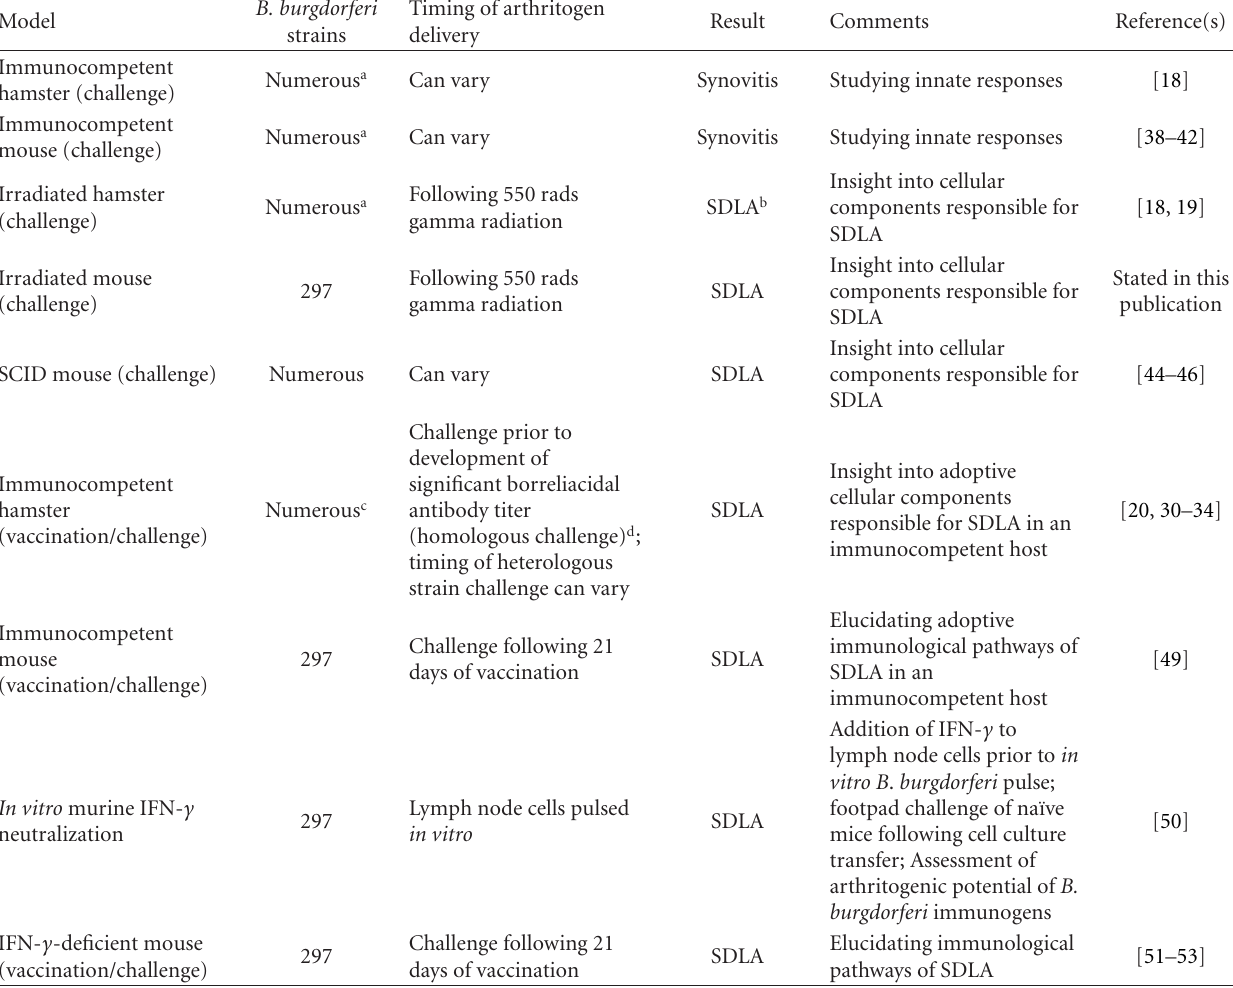
Table 1: Hamster and murine models important for evaluation of the pathogenesis of severe destructive Lyme arthritis.